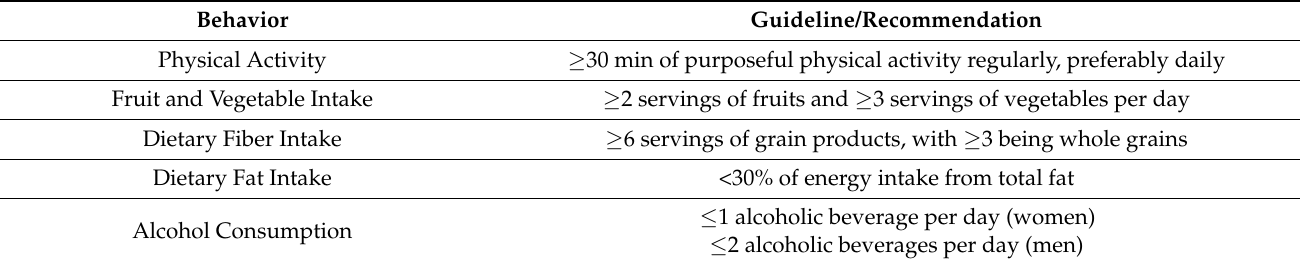
Table 1. Key Recommendations from the 2015 Dietary Guidelines for Americans.